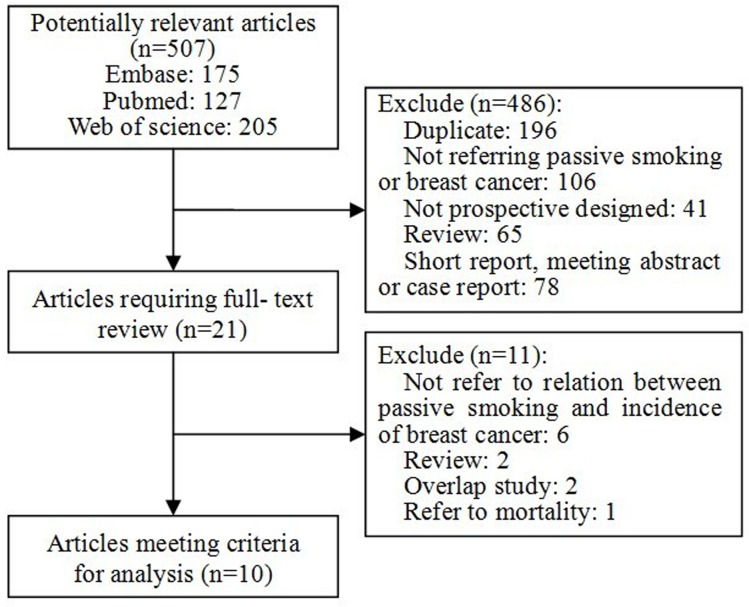
Flow chart of literatures selection.Flow chart shows literature search for prospective cohort studies of passive smoking in relation to incidence of breast cancer.